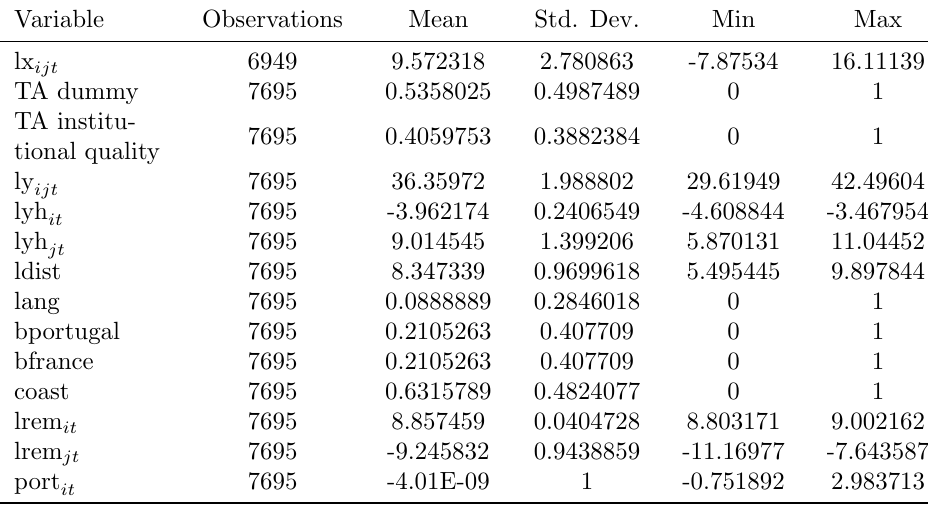
Table A.1: Descriptive statistics